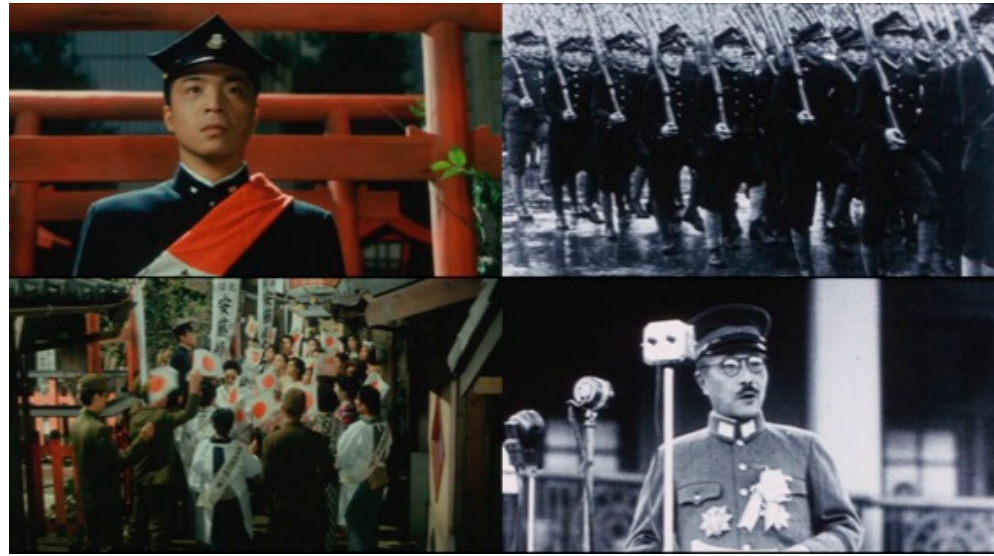
Figure 8. The Strange Story of Oyuki (Shind ō Kaneto, 1992).